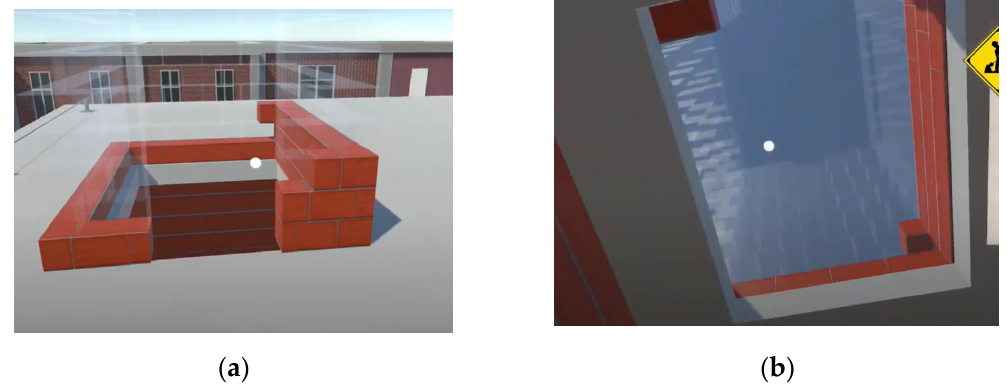
Figure 5. Classification of the level of risk associated with the construction of building columns in Autodesk Revit.